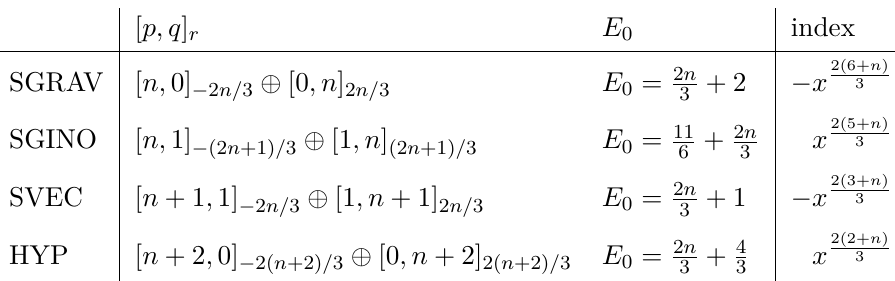
Table 2 . The spectrum of the short multiplets at the Kaluza-Klein level n and the contributions to the superconformal index for N = 2 SU(3) × U(1) invariant AdS 4 solution in massive IIA